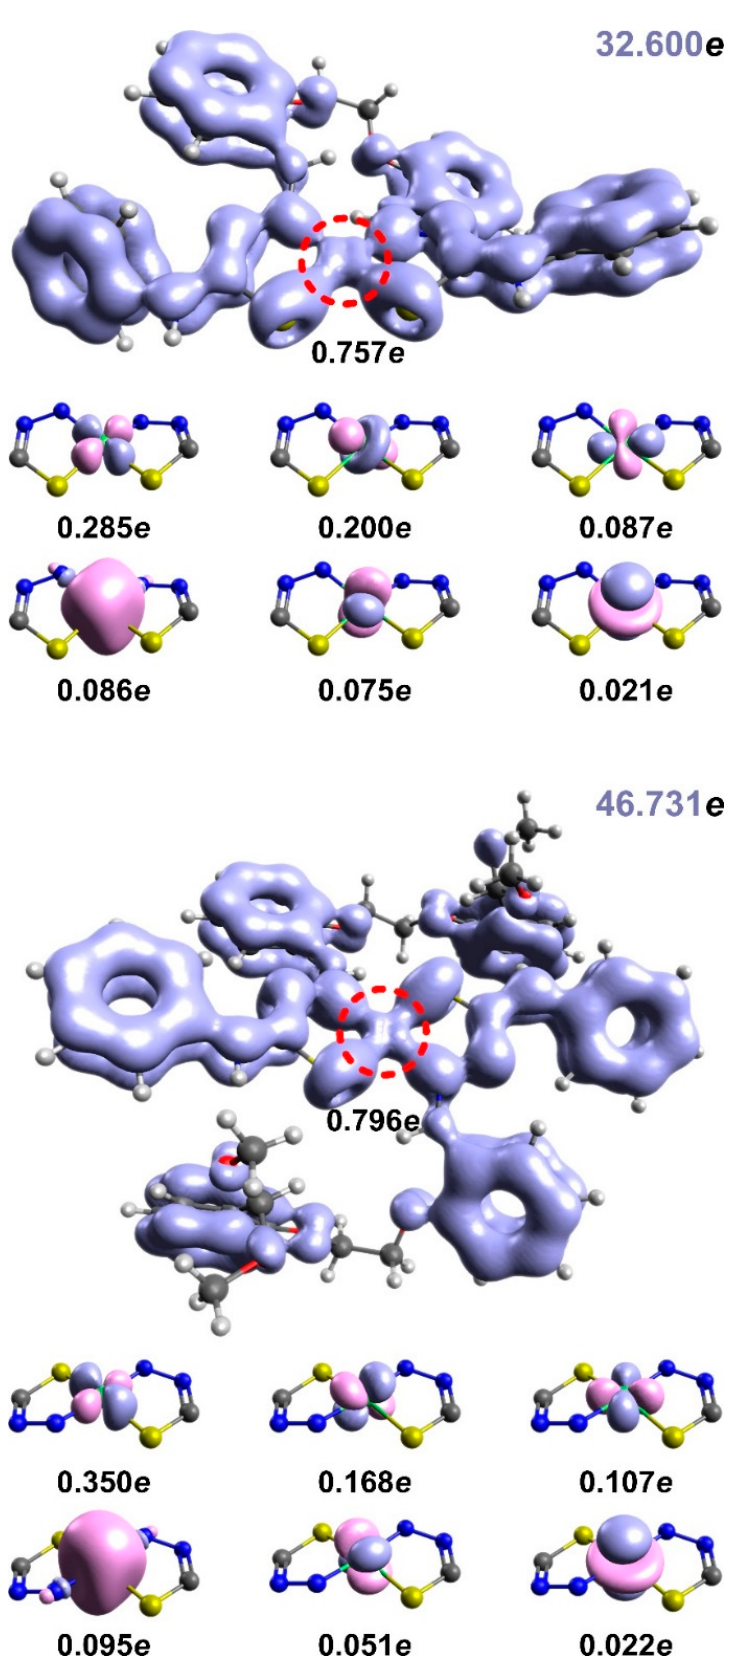
Figure 11. EDDB(r) contours together with populations for 1 (top) and 2 (bottom). Additionally, the involvement of the nickel(II) d-orbitals is depicted.